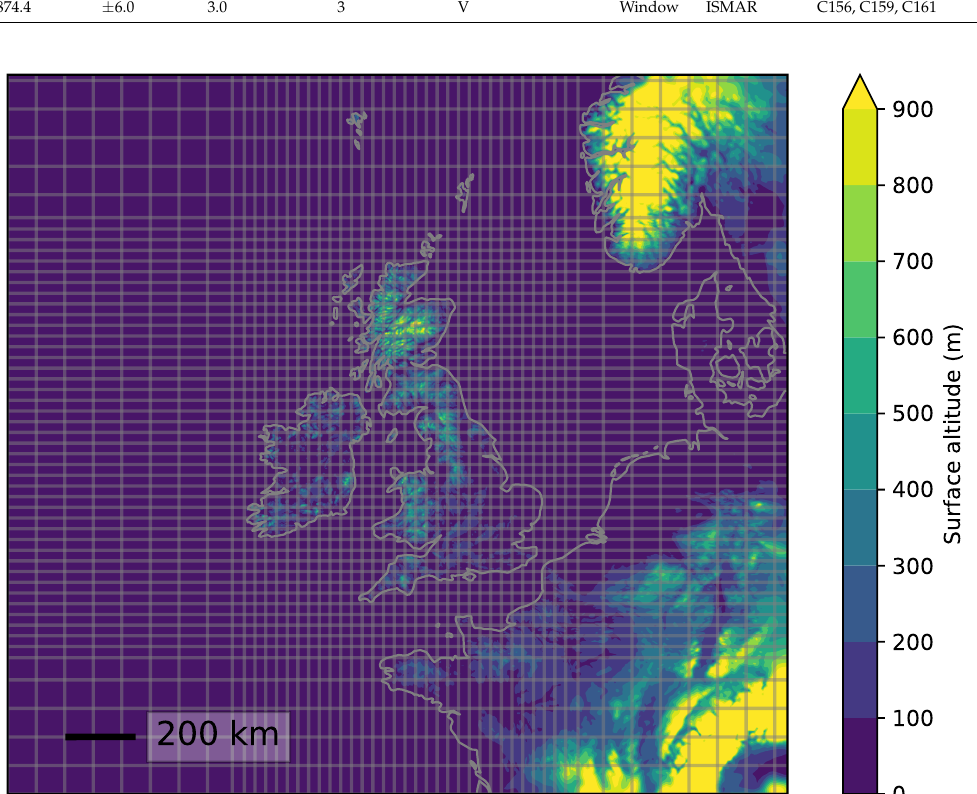
Figure 1. The domain of the NWP model used in this study. The colours indicate the surface altitude. The grey lines are drawn every 20 grid points and indicate the horizontal resolution, which is 1.5 km in the inner region and decreases to 4 km in the outer